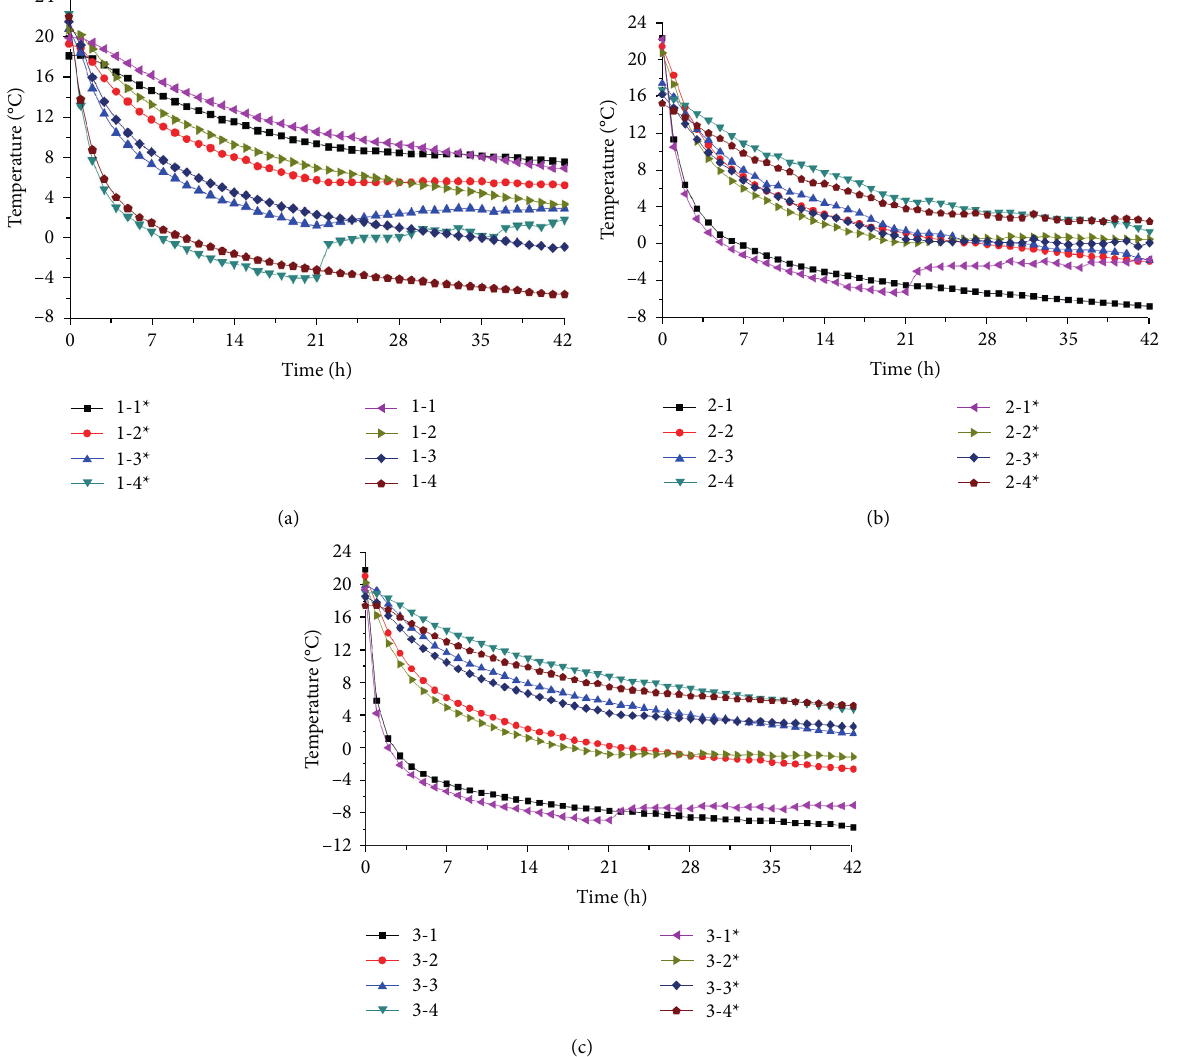
Figure 8: Temperature-time curves of SCF: (a) 90 ° monitoring points; (b) 45 ° monitoring points; (c) 0 ° monitoring